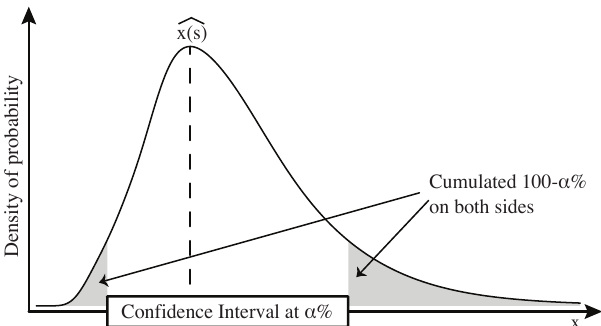
Figure 2. Calculation of a CI exemplified with a right-skewed PDF var . More values are rejected on the right-hand side of the cli- mate gradient. The grey areas cover an area representing α %.